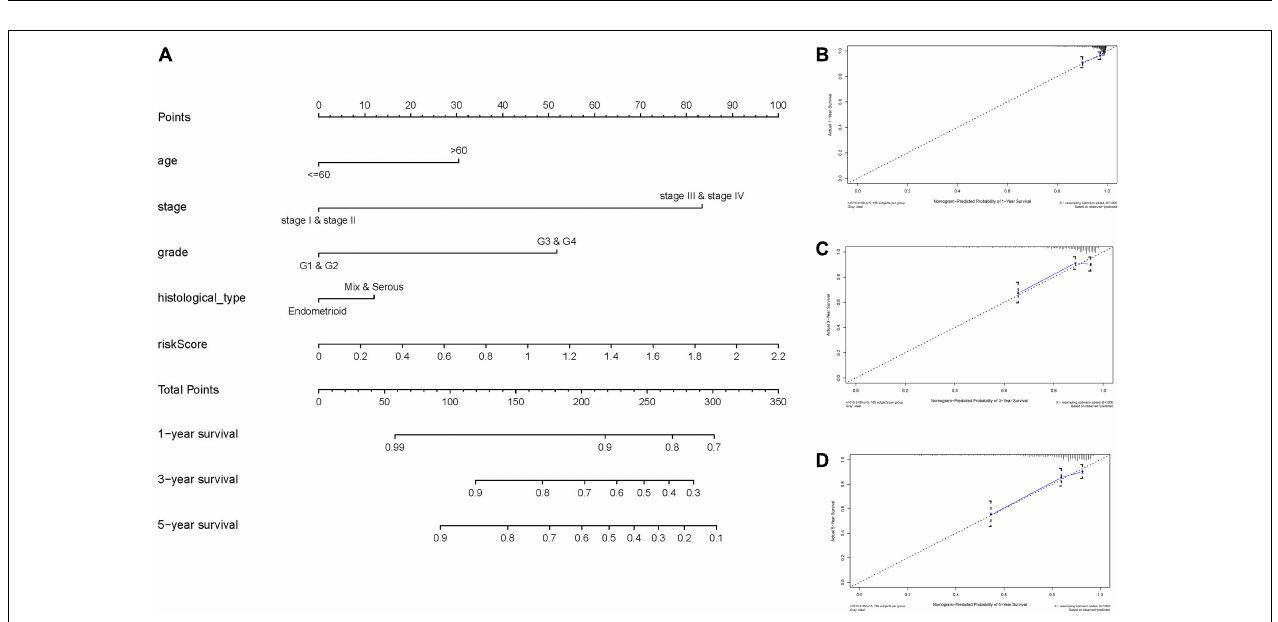
FIGURE 6 | Construction and validation of a nomogram. (A) Nomogram to predict the probability of 1-, 3-, and 5-year OS of UCEC patients. (B–D) Calibration curves of the nomogram to predict the probability of OS at 1, 3, and 5 years.